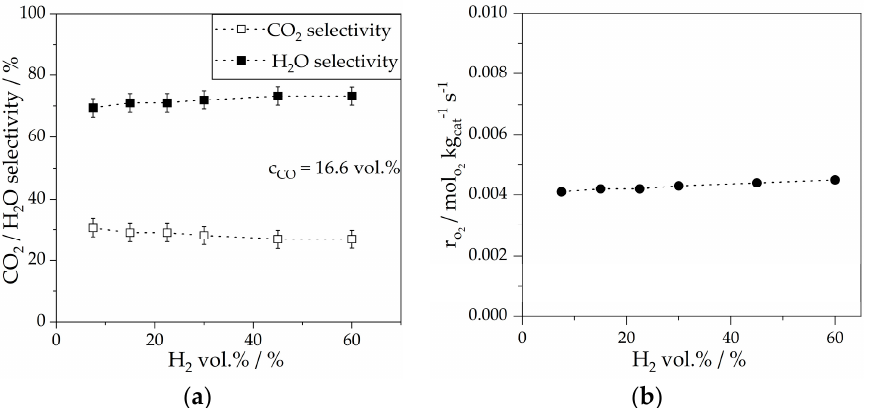
. V total = 15.9 L/h (NTP); p CO = 3.3 bar; = 2